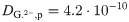
Comparison of concentration profiles from FEM simulations and approximate analytic expressions.The concentration of Gd(DTPA)2− vs z from FEM simulations (solid lines) and from Eqs 18 and 19 and Equation W in S1 Appendix (dashed lines) for a polyelectrolyte solution with an FCD of (A) -50 mM, (B) -108 mM and (C) -150 mM. Parameters used in the calculations A; DG.2−,p=4.2⋅10−10 m2/s, ΔμNa+corr=−0.0736RT, ΔμCl−corr=−0.041RT, ΔμG.2−corr=−0.125RT. B; values in Table 1. C; DG.2−,p=3.5⋅10−10 m2/s, ΔμNa+corr=−0.140RT, ΔμCl−corr=−0.095RT, ΔμG.2−corr=−0.318RT.